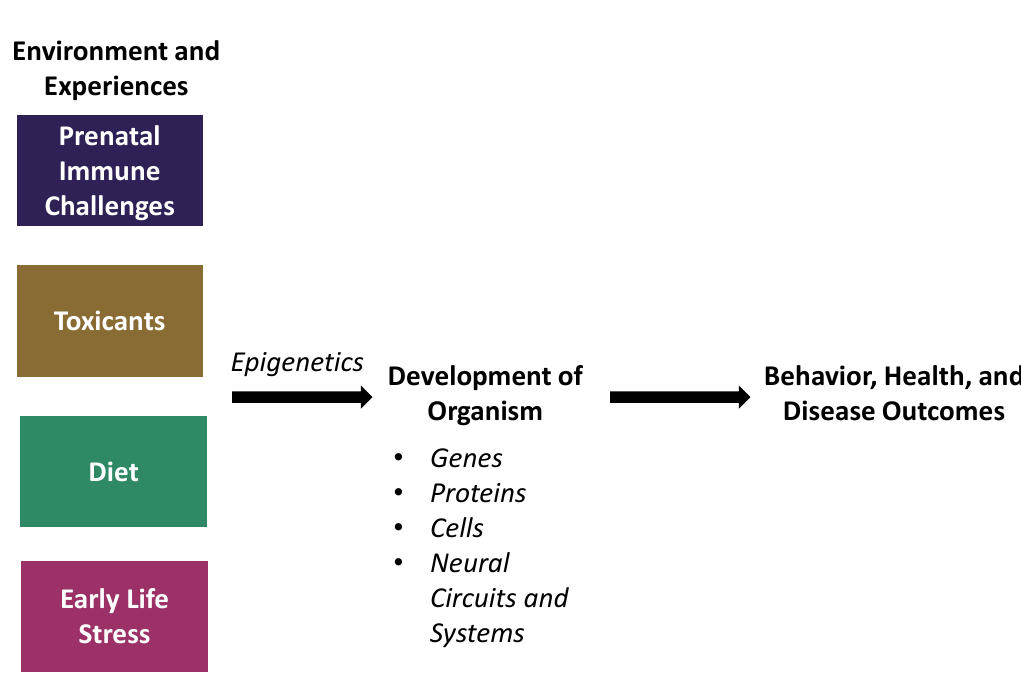
Figure 2. Factors in the environment in addition to experiences throughout the lifespan can influence the development of an organism via epigenetic mechanisms, thus altering subsequent behavior, health, and disease